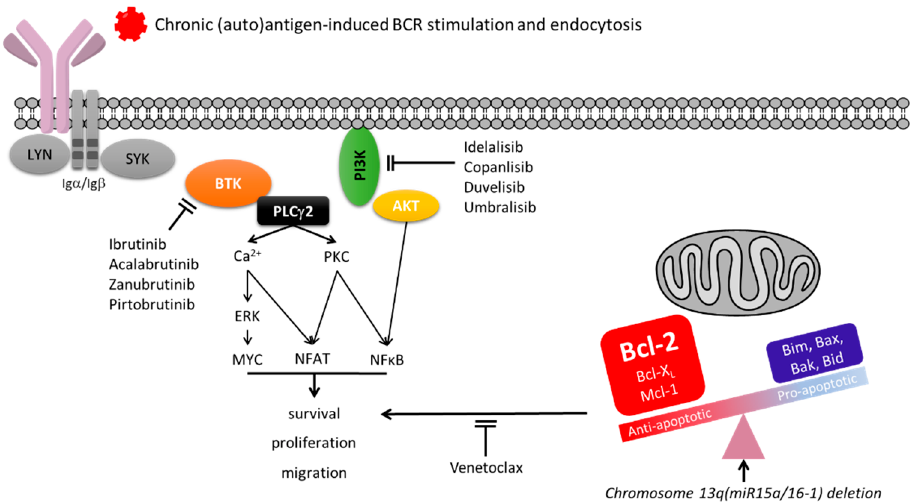
Figure 2. Simplified diagram of BCR signaling and therapeutic targeting in CLL. BCR engagement by (auto)antigen leads to the proximal activation of a complex of kinases and scaffold proteins, initiating with the phosphorylation of the immunoreceptor tyrosine-based activation motifs (ITAMs) in the C-terminal tail of BCR-associated Ig α /CD79a and Ig β /CD79b by LYN. Phosphorylated ITAMs leads to SYK recruitment and propagation of signal to Bruton tyrosine kinase (BTK) and phospholipase C γ 2 (PLC γ 2). LYN-dependent phosphorylation of the cytoplasmic domain of CD19 also recruits phosphoinositide 3-kinase (PI3K). Activation of a network of distal signaling molecules follows. Activation of PLC γ 2 leads to the release of intracellular Ca2+ and activates protein kinase C (PKC). PKC subsequently induces the activation of transcription factors, including NF- κ B and nuclear factor of activated T cells (NFAT). Recruitment of PI3K to the plasma membrane leads to optimal activation of BTK and AKT. PLC γ 2 is also involved in the activation of mitogen-activated protein kinase (MAPK) pathways, including the extracellular signal-regulated kinase 1/2 (ERK). The third phase of events involves modulation of multiple downstream regulators, which ultimately mediate changes in cell proliferation, survival, and migration, via both phosphorylation and transcriptional modulation of key regulators of cell survival (e.g., Mcl-1, Bim). In CLL, strength of BCR signal, which is controlled by surface IgM levels, will determine cell fate with a balance towards anergy particularly when sIgM levels are low. MiR15a/16-1 deletion at chromosome 13, allowing overexpression of antiapoptotic Bcl-2 protein favoring survival, counter the proapoptotic mechanisms associated with anergy. Therapeutical inhibition of BTK variably blocks BCR signaling in CLL depending, amongst other factors, on sIgM levels and signal strength. Addition of PI3K inhibitors may fully suppress the residual signaling activity. BH3 mimetics (venetoclax) block the antiapoptotic mechanisms resulting from Bcl-2 overexpression found in CLL.